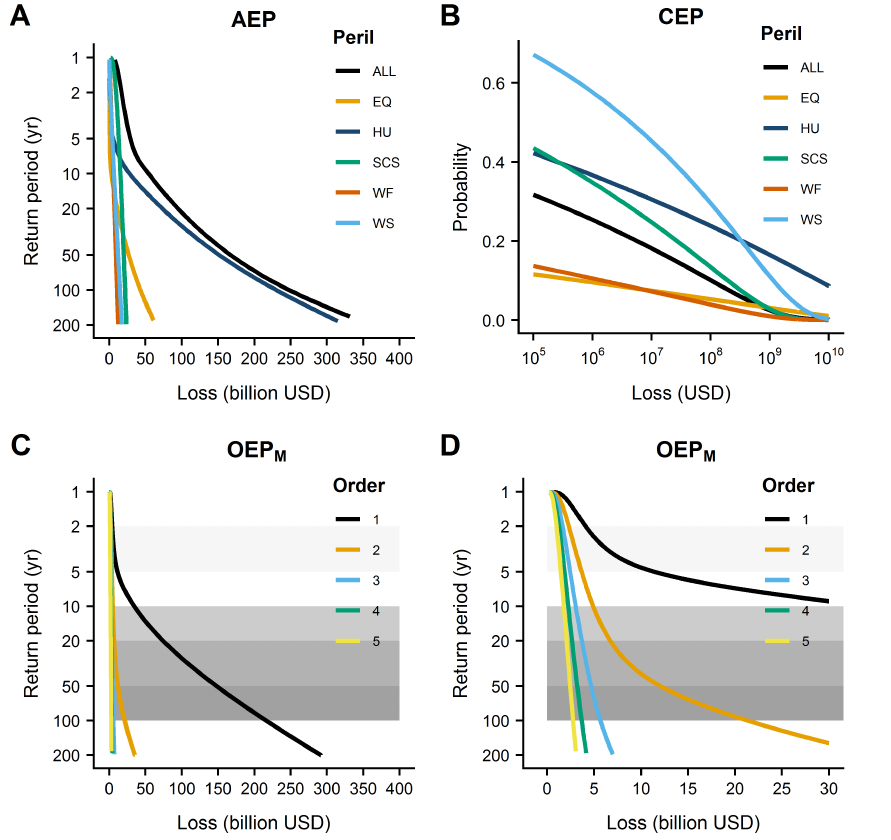
Figure 4. ( Panel A ) depicts the AEP for the individual peril models, as well as the multi-peril model denoted by ALL. ( Panel B ) depicts the exceedance probability of the individual severity distributions, as well as the multi-peril model. ( Panels C,D ) depict the exceedance probability curves for the occurrence loss marginal distributions up to order M =